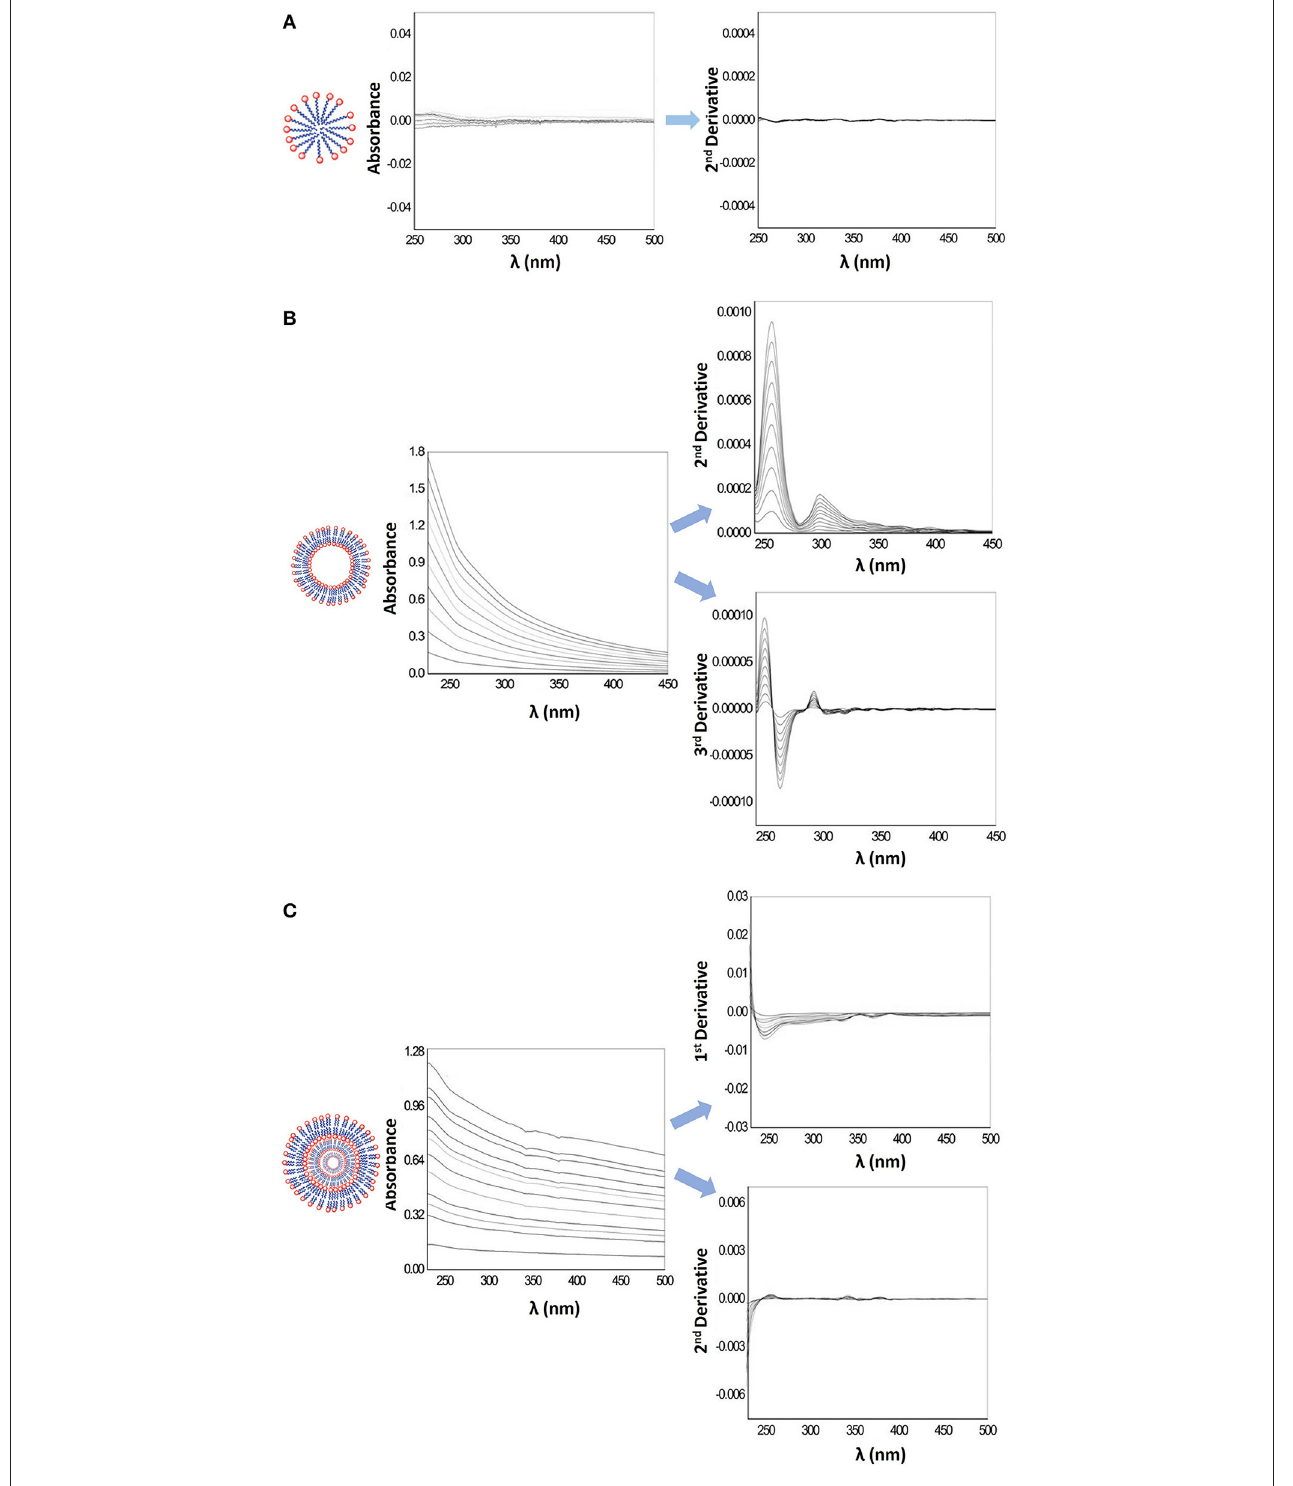
FIGURE 2 | (A) Representative scheme of a micelle, its absorption spectra and second derivative spectra obtained for increasing HDPC concentrations (100–900 µ M) in Hepes buffer pH = 7.4 and I = 0.1M. (B) Representative scheme of LUVs, its absorption spectra and second and third derivative spectra obtained for increasing concentrations liposomes (100–1,000 µ M) in Hepes buffer pH = 7.4 and I = 0.1M. (C) Representative scheme of MLVs, its absorption spectra and first and second derivative spectra obtained for increasing concentrations of liposomes (40–350 µ M) in Hepes buffer pH = 7.4 and I = 0.1M.